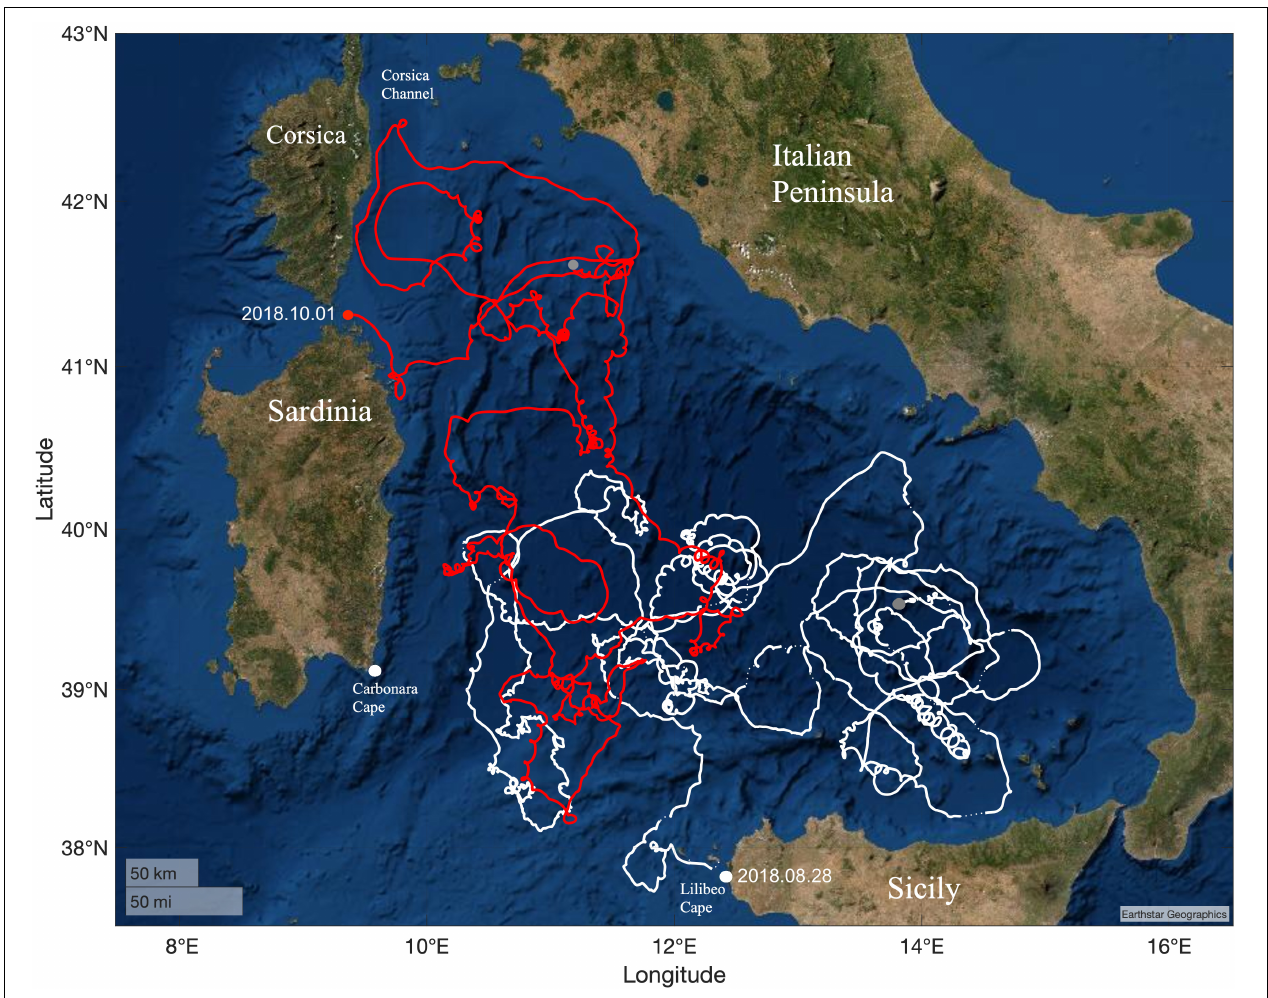
FIGURE 1 | Trajectories of the loggerhead turtle (LT, white line) and of the drifter (OBS, red line). LT trajectory starts at Favignana Island (Sicily), off Lilibeo Cape, on 28 August 2018 and stops at the gray circle on 31 July 2019; the dashed white segments were excluded from the analysis (see section “Materials and Methods”). OBS trajectory starts at north Sardinia (red circle) on 1 October 2018 and stops in the northern Tyrrhenian Sea on 31 May 2019 (gray